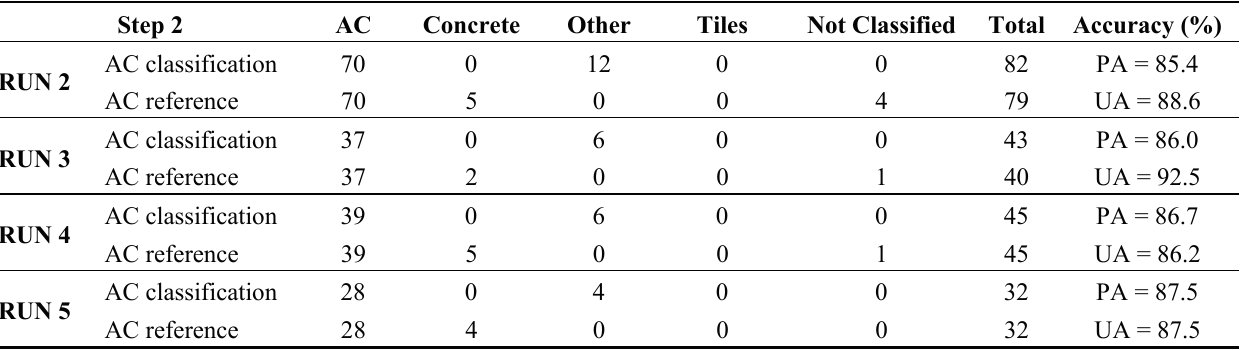
Table 2. Step 2: Classification accuracy assessment for RUN 2, 3, 4 and 5.